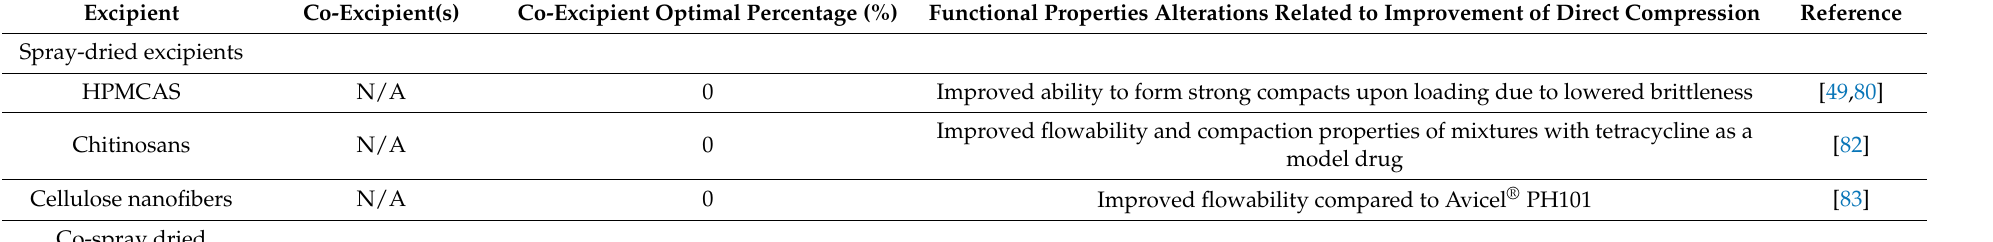
Table 2. Illustrative studies attempting direct compression of excipients by spray drying alone or with other